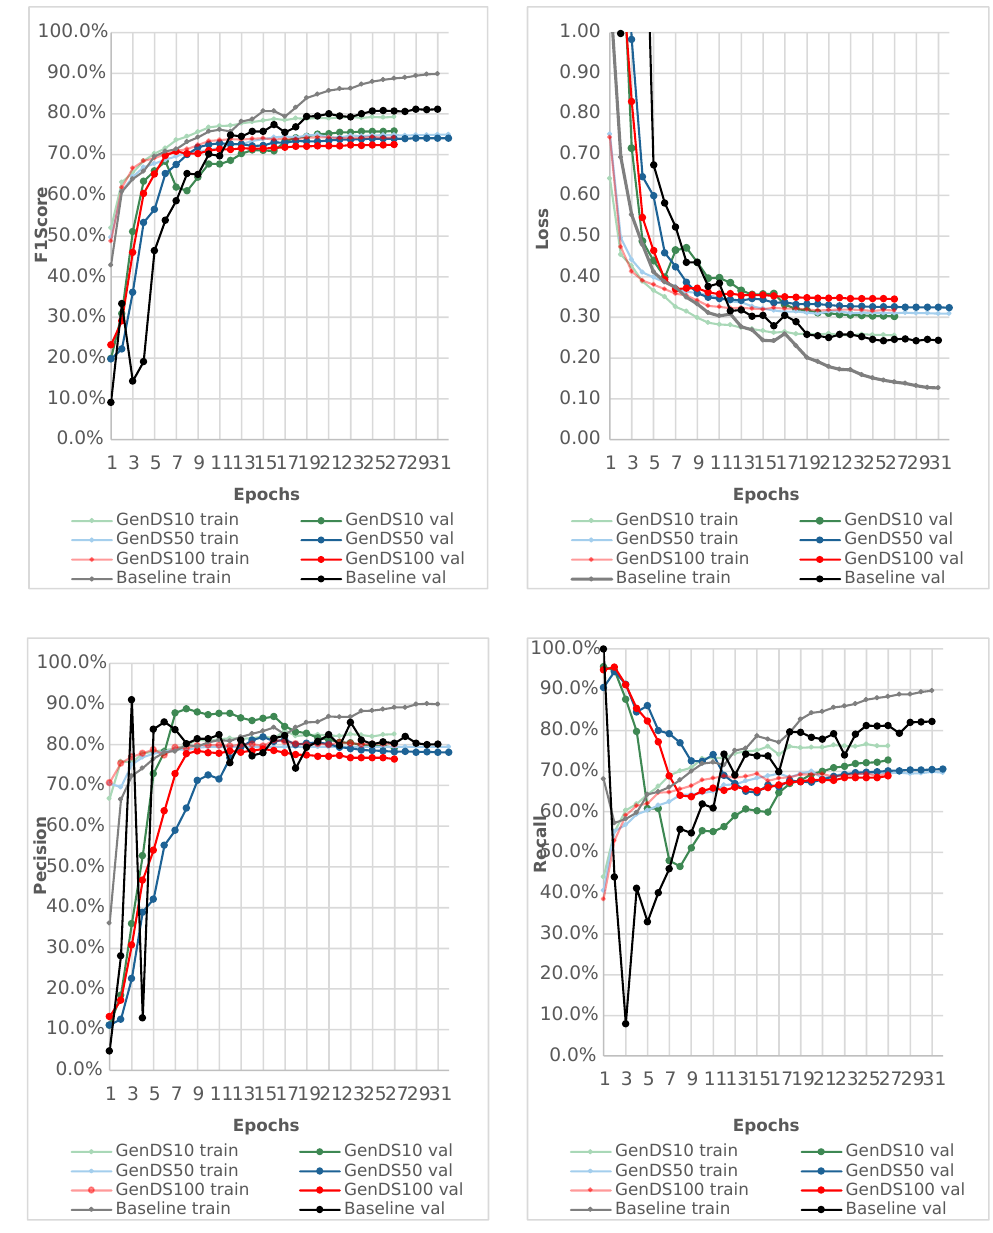
Figure 6. Training and validation performance in training stage 2 with specific training